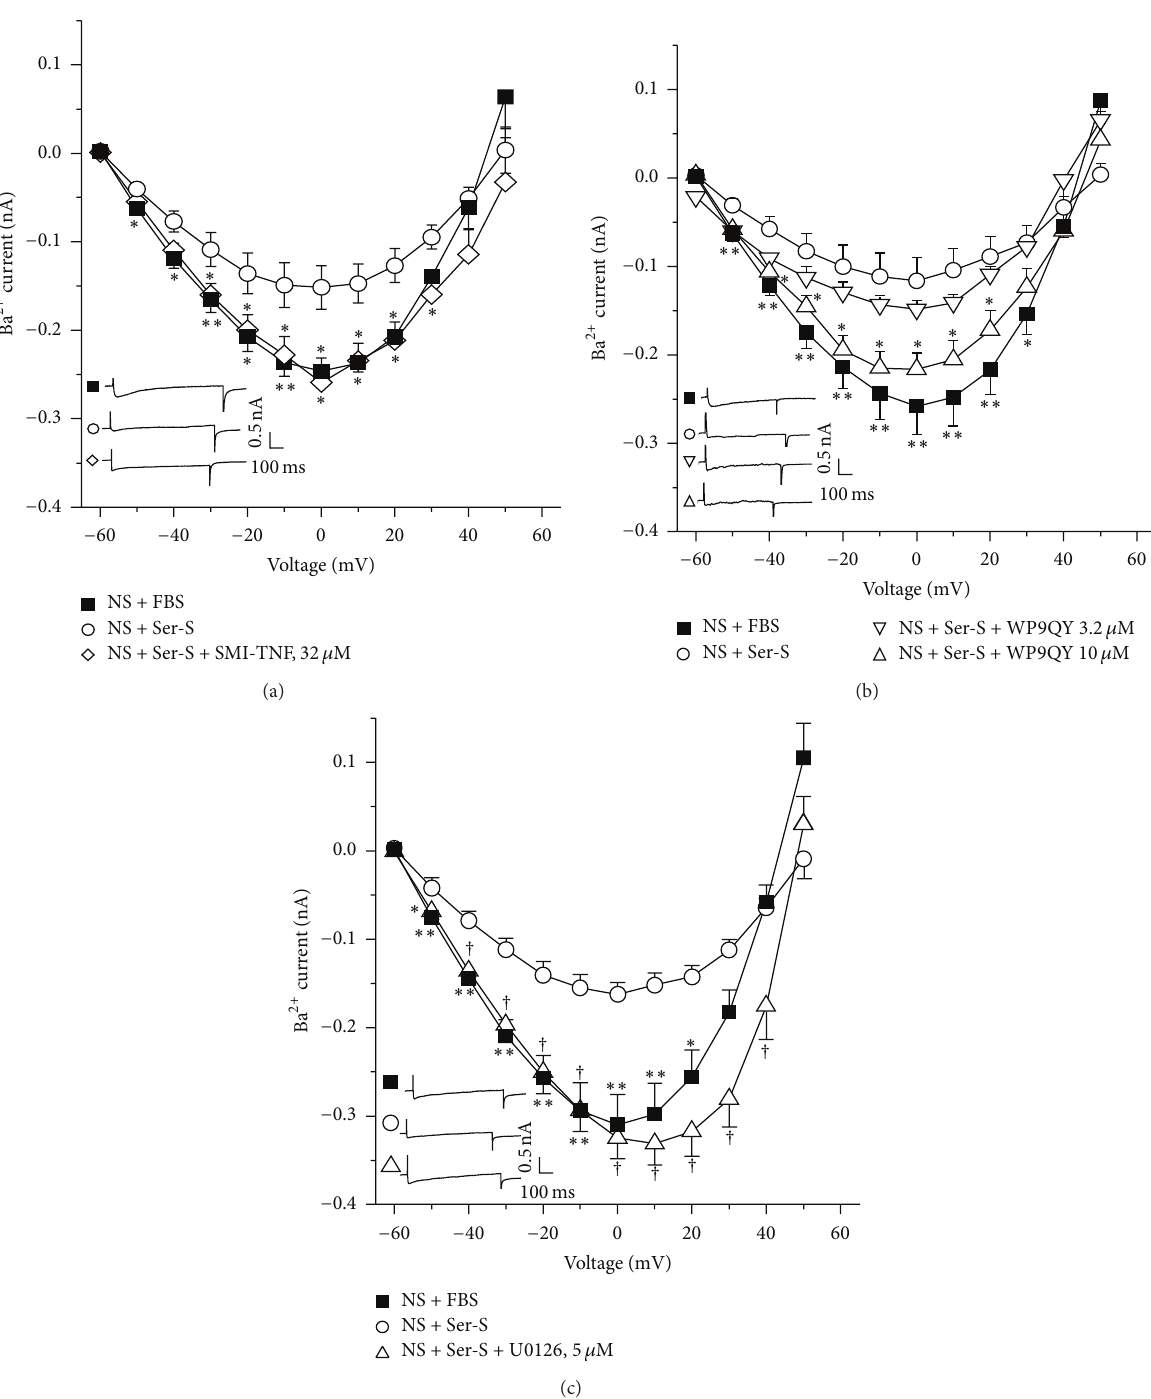
Figure3:TNF- 𝛼 diminishestheL-typeCa 2+ currentsthroughactivationoftheTNF- 𝛼 receptor1(TNFR1)andMAPkinasesignalingpathway in guinea pig tracheal myocytes. (a) Myocytes from nonsensitized animals (NS) grown with fetal bovine serum (FBS) showed an inward Ba 2+ current. This current was reduced when NS myocytes were grown with serum from sensitized guinea pig (Ser-S, 10%). This decrease was abolished when the small-molecule inhibitor of TNF- 𝛼 (SMI-TNF, 𝑛 = 7 ), which impedes this cytokine from binding to its